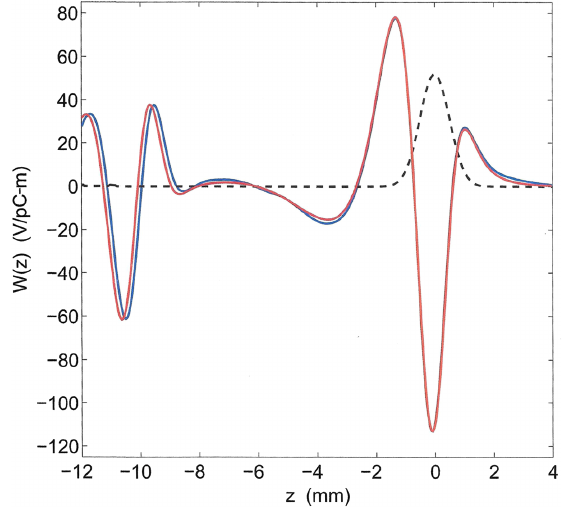
FIG. 23. Wakefield (blue) to compare with Fig. 3(b) of [4]